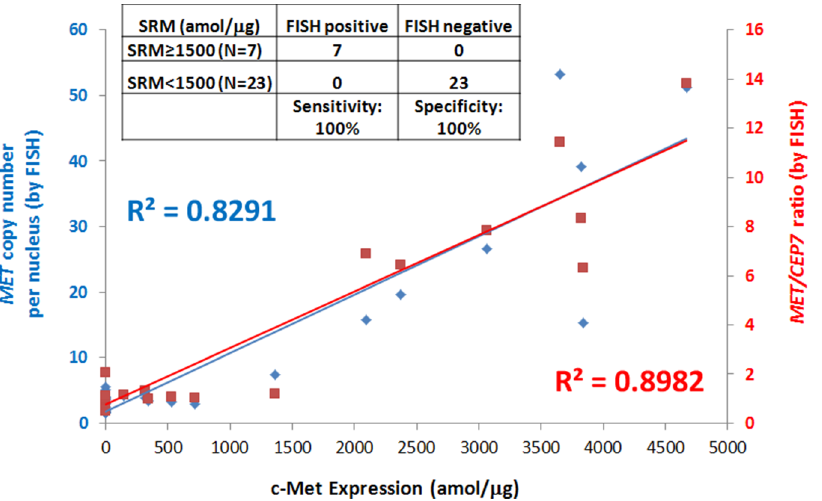
Figure 7. Correlation of Met levels using Liquid Tissue-SRM and MET gene amplification by FISH in 30 GEC tumors. This cohort includes diploid/low polyploid, high polyploid, and amplified samples. The left y-axis (blue diamond) represents the MET copy number per nucleus and the right y-axis (red square) indicates MET:CEP7 ratio.